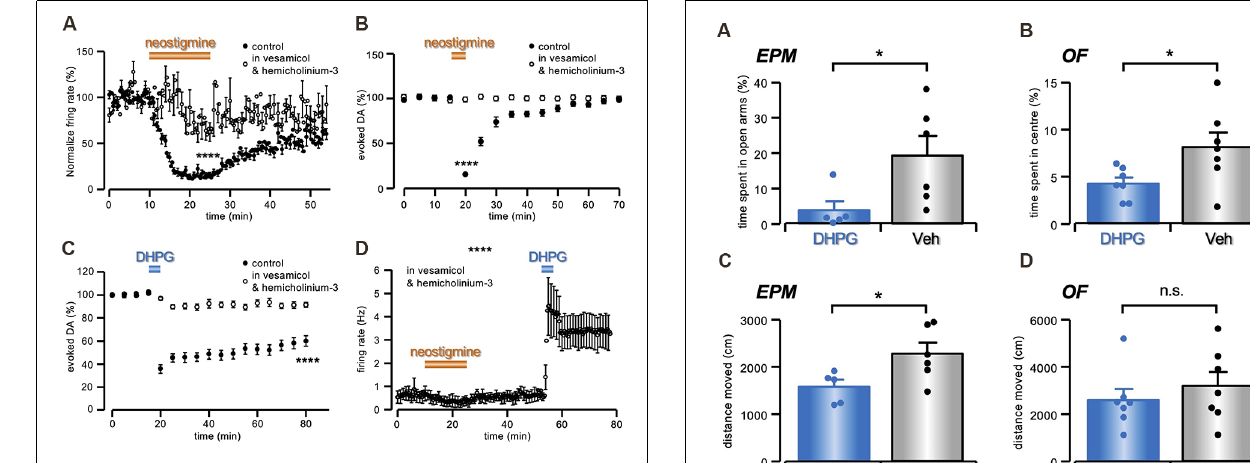
FIGURE 5 | ACh depletion prevents DA-LTD. (A) Running plots of the firing rate (mean ± s.e.m. binned every 20 s) of spontaneously active neurons in striatal slices, recorded with MEA. While in control conditions neostigmine (1 µ M) inhibited ChIs firing ( n = 70, from four slices and three animals), this effect was reduced in slices preincubated for at least 2 h and continuously perfused in 10 µ M vesamicol and 10 µ M hemicholinium-3 ( n = 52, from six slices and three animals). (B,C) Running plot of the relative mean amplitude ( ± s.e.m.) of evoked DA release, obtained with amperometric recordings at 5 min intervals. (B) Neostigmine (1 µ M) reversibly inhibited evoked DA release in control conditions ( n = 6 slices from three animals), while no change was observed in slices preincubated for at least 2 h and continuously perfused in 10 µ M vesamicol and 10 µ M hemicholinium-3 ( n = 6 slices from three animals). (C) No DA-LTD was observed in slices preincubated for at least 2 h and continuously perfused in 10 µ M vesamicol and 10 µ M hemicholinium-3, following 5 min perfusion with 50 µ M DHPG ( n = 12 slices from six animals). The control plot is the same as illustrated in Figure 1 . (D) Under the same conditions of vesamicol (10 µ M) and hemicholinium-3 (10 µ M), neostigmine (30 µ M) produced a slight firing inhibition of presumed ChIs recorded with MEA (as in panel A ), while the sustained increase of the firing rate in response to 5 min perfusion with DHPG (50 µ M) was still evident ( n = 6, from one slice and one animal). **** P < 0.0001, Student’s t-test for unpaired data.